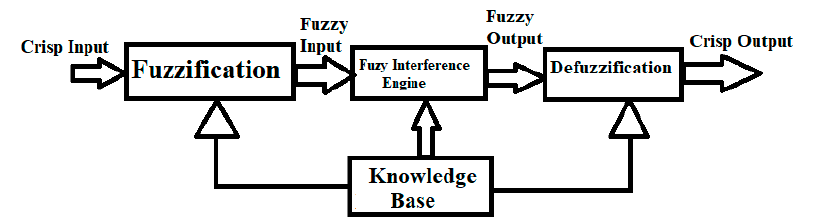
Figure 4. T1FLC inference process